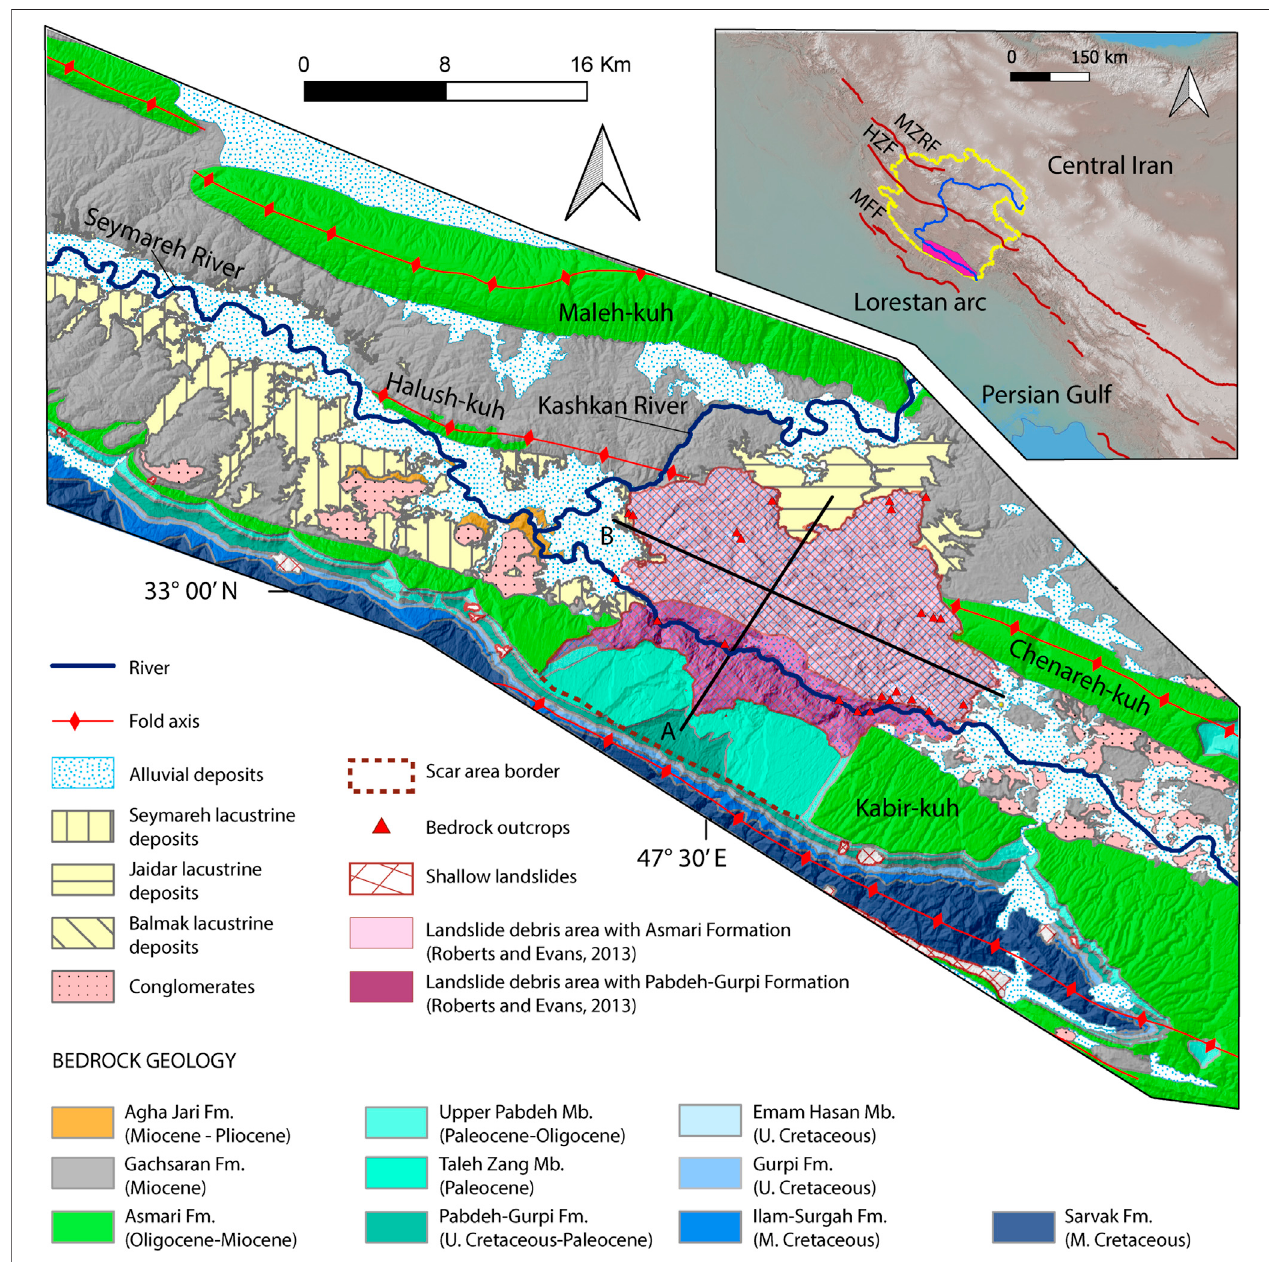
FIGURE 1 | Geological map of the Seymareh landslide area. The geological data are provided by the National Iranian Oil Company (NIOC) at a scale of 1:100,000 (Setudehnia and Perry, 1967; Macleod, 1970; Takin et al., 1970). The traces (A,B) of the geological cross sections shown in Figure 8 are reported. The coordinate reference system is